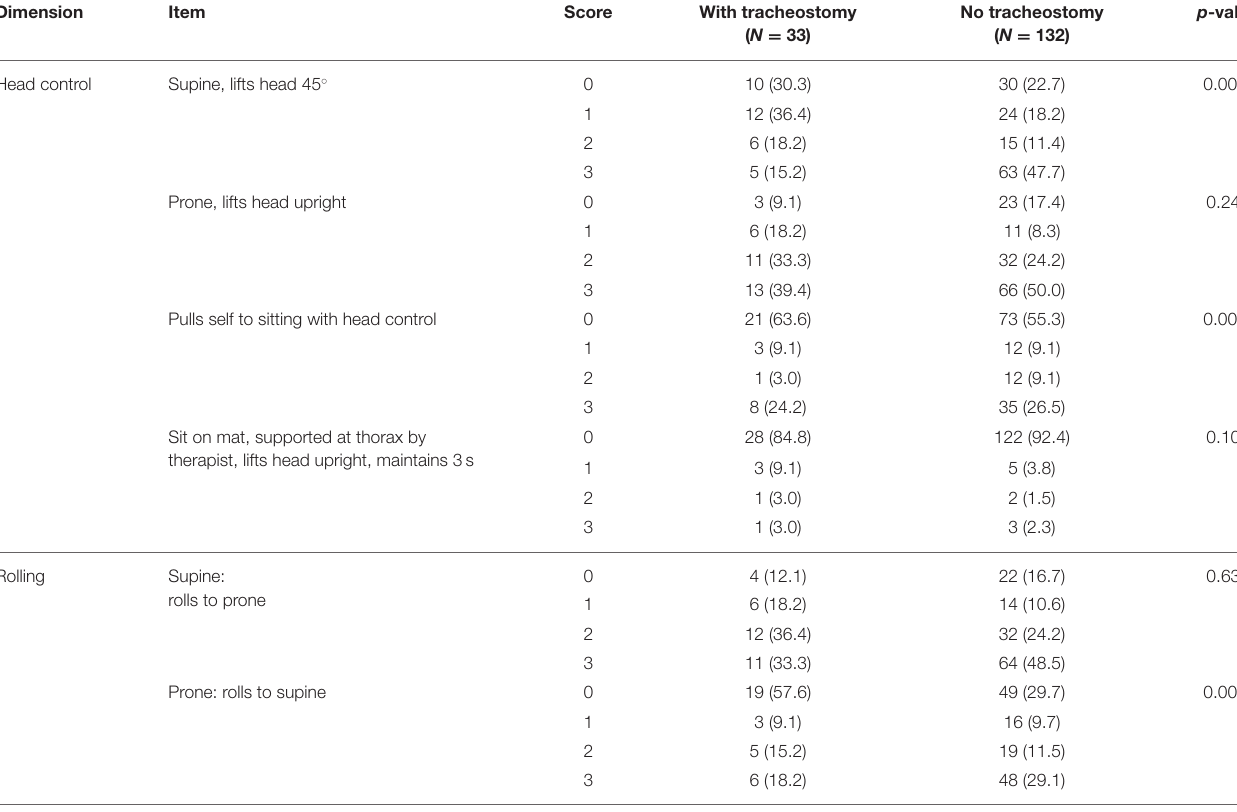
TABLE 2 | Gross motor function measure value of items of head control and rolling between tracheostomy and no tracheostomy groups. Dimension